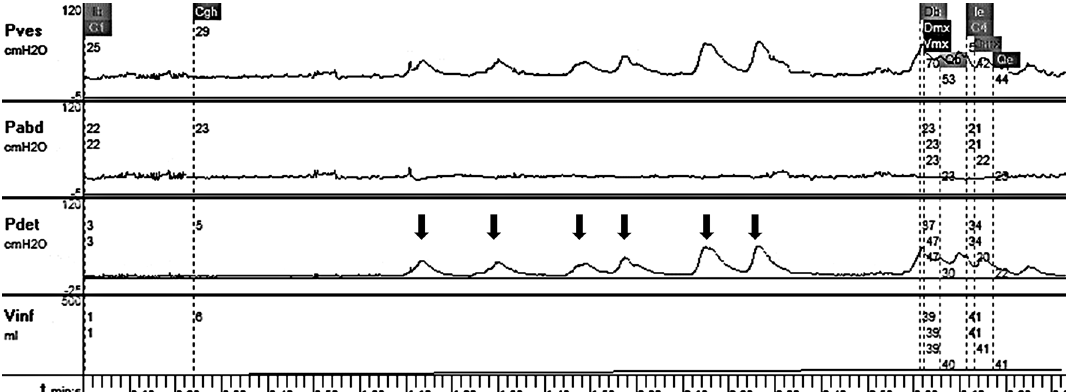
Figure 1. Representative urodynamic result of spastic cerebral palsy showing involuntary detrusor overactivity during filling phase. Pdet Pves–Pabd. X-axis time, Y-axis pressure (cm H 2 O). Arrows: non-voiding